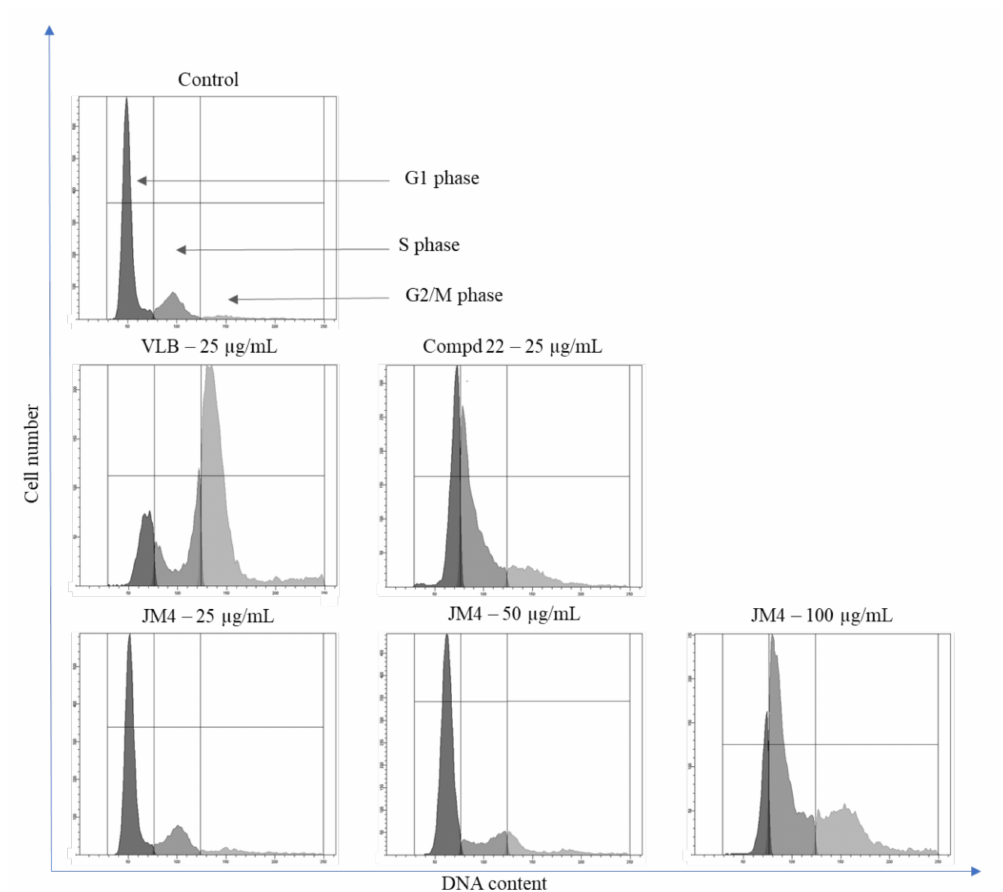
Figure 3. Flow cytometric analysis of cell cycle of C32 melanoma cells after 24 h of incubation with JM4 (25, 50, 100 µ g/mL), 22 (25 µ g/mL) and vinblastine sulfate (VLB) (25 µ g/mL) using propidium iodide (PI) staining.